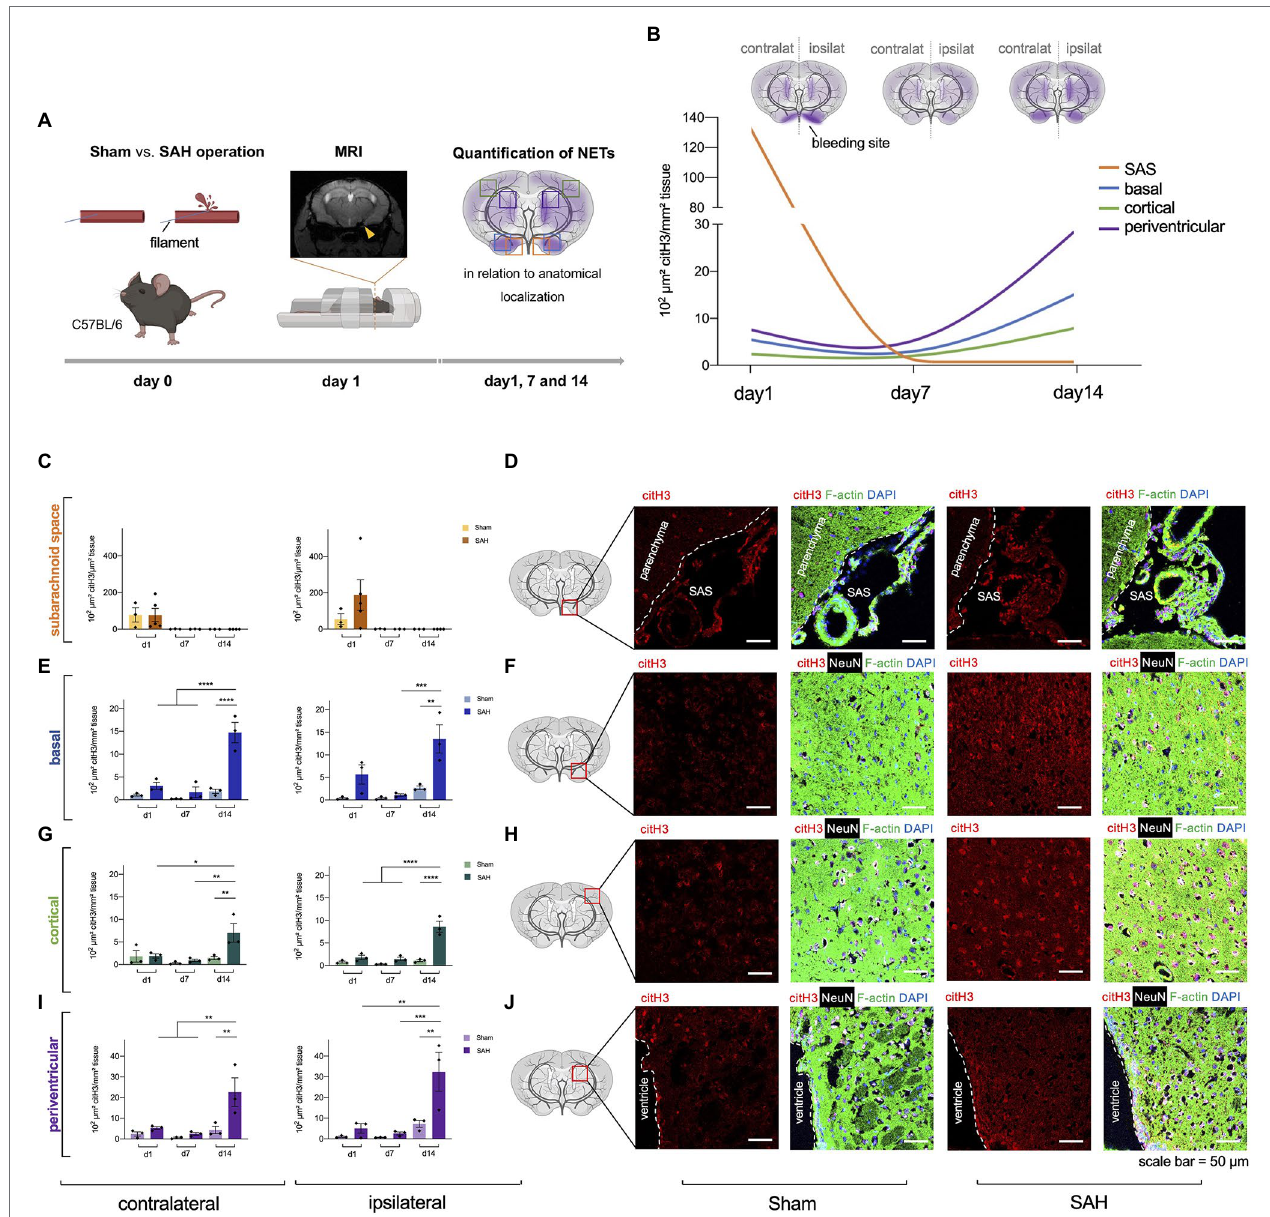
FIGURE 1 | Neutrophil extracellular traps (NETs) are increased in subarachnoid hemorrhage (SAH). (A) The filament perforation model was utilized to induce SAH in C57BL/6 mice. MRI was done 24 h after SAH onset to verify bleeding and exclude stroke or intracerebral hemorrhage, and NETs were quantified via immunofluorescence in relation to anatomical localization on three different time points (day 1, 7, and 14). (B) Cumulative data of NETs accumulation in SAH condition over time. (C,D) Quantification of NETs in subarachnoid space (SAS) with representative immunofluorescence staining of extracellular citH3 (exCitH3), F-actin, NeuN, and DAPI. Sham, n = 3 for each time point; SAH, n = 5 for each time point. (E–J) Quantification of NETs in basal, cortical, and periventricular parenchyma with representative immunofluorescence staining of citH3 (citrullinated H3), F-actin, NeuN, and DAPI on day 1, 7, and 14. Sham, n = 3 for each time point; SAH, n = 3 for each time point. contralat., contralateral; ipsilat., ipsilateral. Scale bar = 50 μ m. * p < 0.05, ** p < 0.01, *** p < 0.001, and **** p <